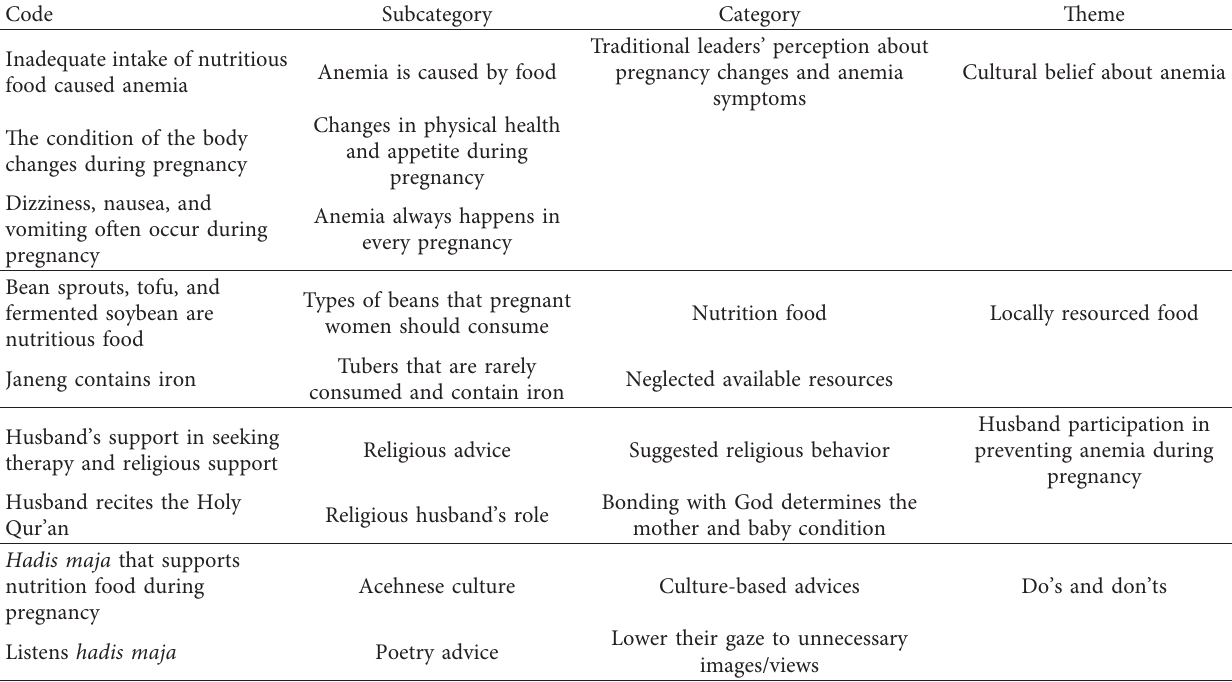
Table 1: Major findings with the code, subcategories, categories, and